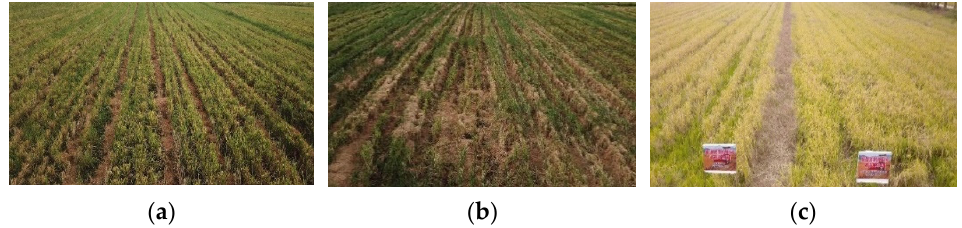
Figure 7. Growth conditions of ratoon rice harvested by machine in the second season. ( a ) A week after being harvested by a double-channel feeding harvester; ( b ) a week after being harvested by a common harvester; ( c ) ratoon rice in its mature period.